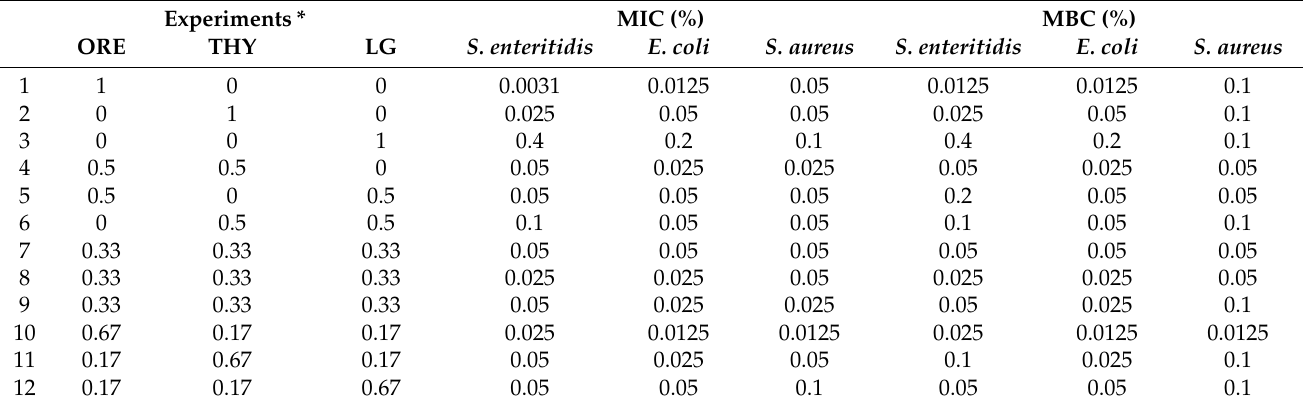
Table 4. Simplex–centroid design experiments, minimum inhibitory concentration (MIC) and min- imum bactericidal concentration (MBC) values of single and blended essential oils (EOs) against Escherichia coli , Staphylococcus aureus , and Salmonella enterica serotype